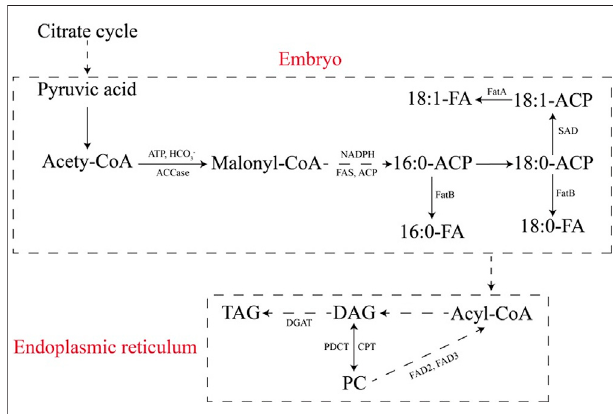
FIGURE 3 | Fatty acid and TAG metabolic pathways in tobacco seeds. ACCase, acetyl-CoA carboxylase; FAS, fatty acid synthase; ACP, acyl carrier protein; FA, fatty acid; FatA/B, acyl-ACP thioesterases; DAG, diacyl-glycerol; TAG, triacylglycerol; PC, phosphatidylcholine; SAD, stearoyl-ACP desaturase; DGAT, diacylglycerol acyltransferase; PDCT, phosphatidylcholine:diacylglycerol cholinephosphotransferase; CPT, CDP- choline:1,2-diacylglycerol cholinephosphotransferase; FAD2, oleoyl desaturase; FAD3, linoleoyl desaturase (Zhang, et al., 2016b; Zhou et al.,